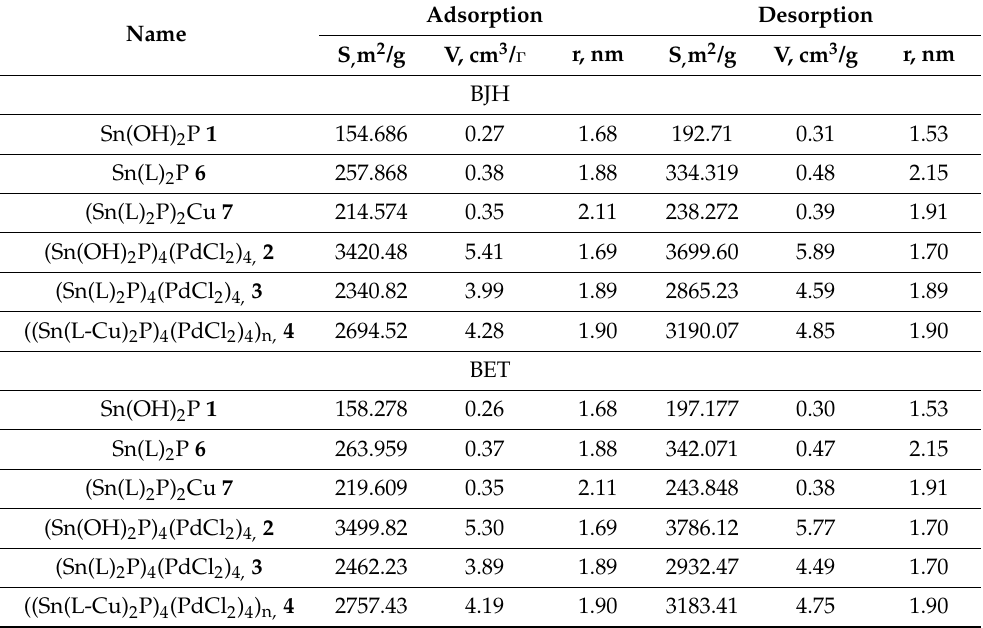
Table 8. Average pore radius ®, pore volume (V), and surface area (S) obtained by the BJH and BET